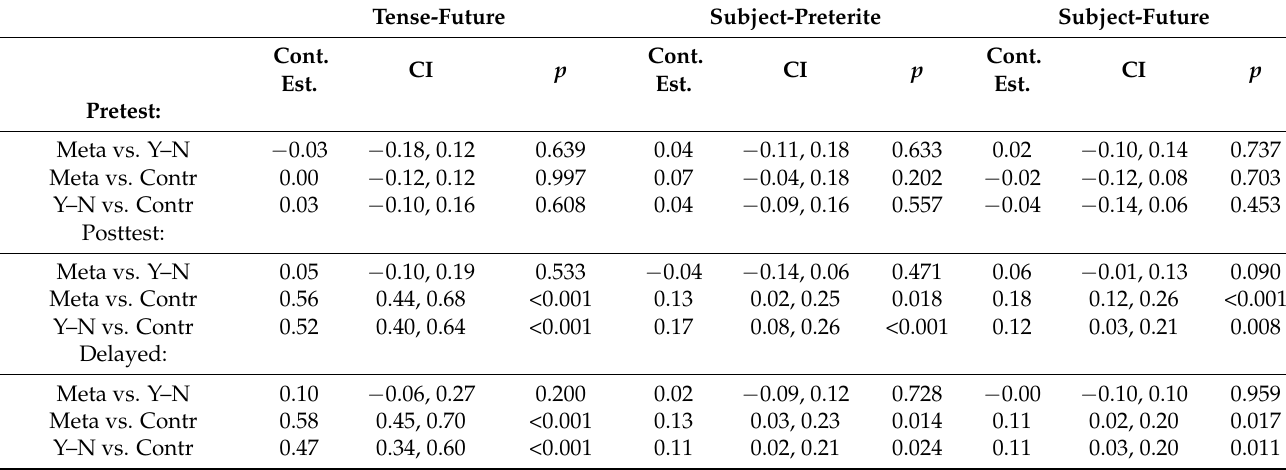
Table 7. Pairwise Comparisons for Time × Group Interactions in Interpretation Assessment